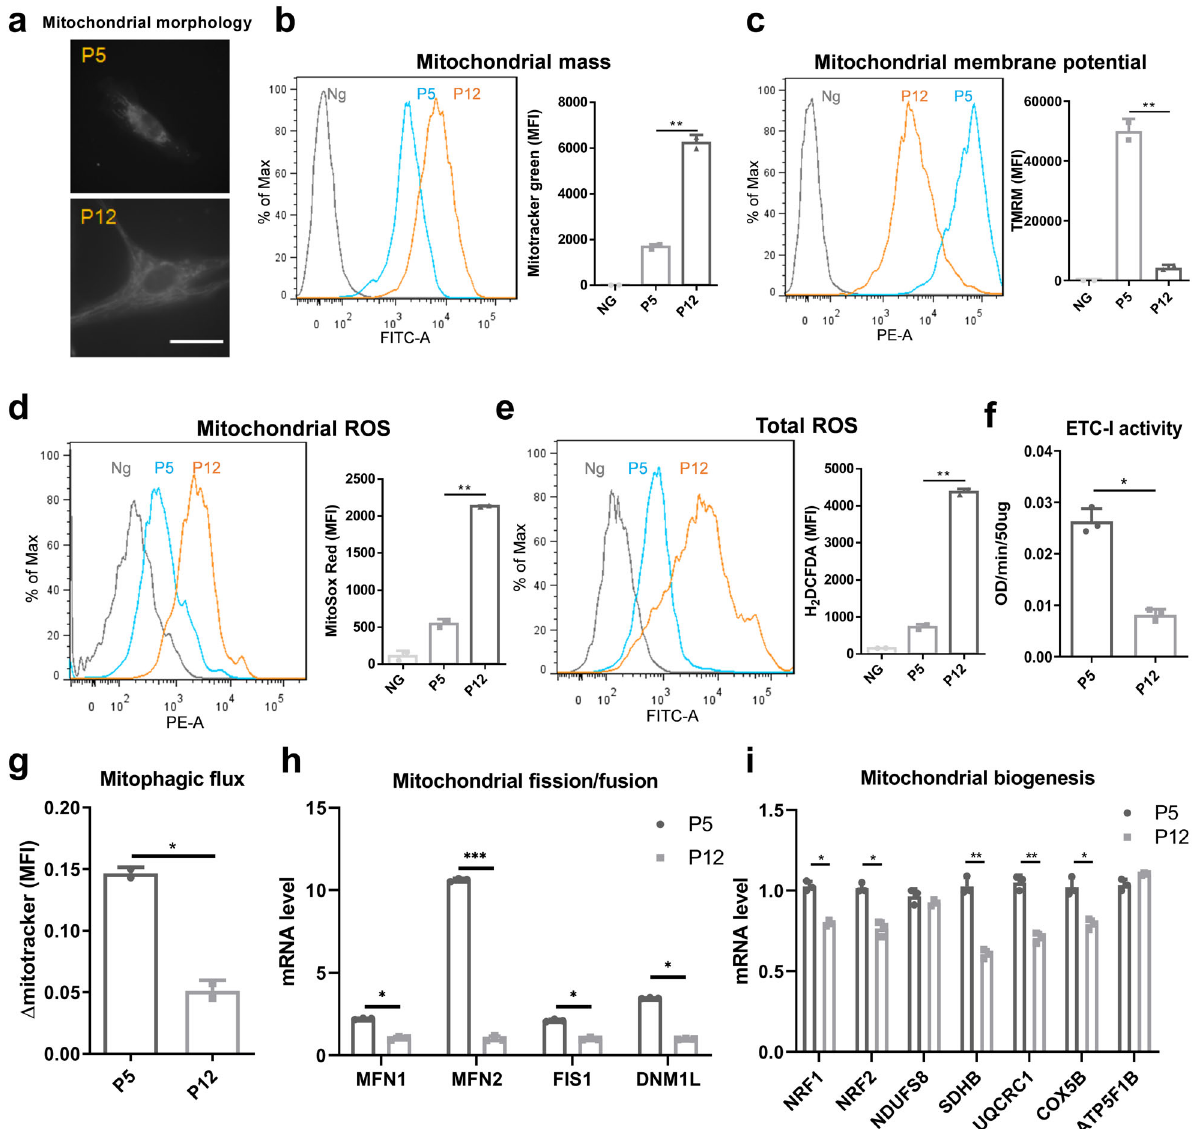
Fig. 2 Culture expansion of human mesenchymal stem cells (hMSCs) induces mitochondrial dysfunction. a Mitochondrial morphology was altered during culture expansion of hMSCs. b Increased mitochondrial mass and c loss of mitochondrial membrane intensity were observed in hMSCs at late passage, both determined by fl ow cytometry. d Mitochondrial reactive oxygen species (ROS) and e total ROS were also increased during in vitro culture expansion of hMSCs. f Electron transport chain complex I (ETC-I) activity was reduced in late passage of hMSCs compared to cells at early passage. g Culture expansion induced loss of hMSC mitophagy, as well as h mitochondrial fusion and fi ssion dynamics determined by mRNA levels. i Genes involved in mitochondrial biogenesis were decreased during culture expansion of hMSCs. Scale bar: 50 µ m. Ng negative control. Biological replicates ( n ): n = 3. * p < 0.05; ** p < 0.01; *** p <